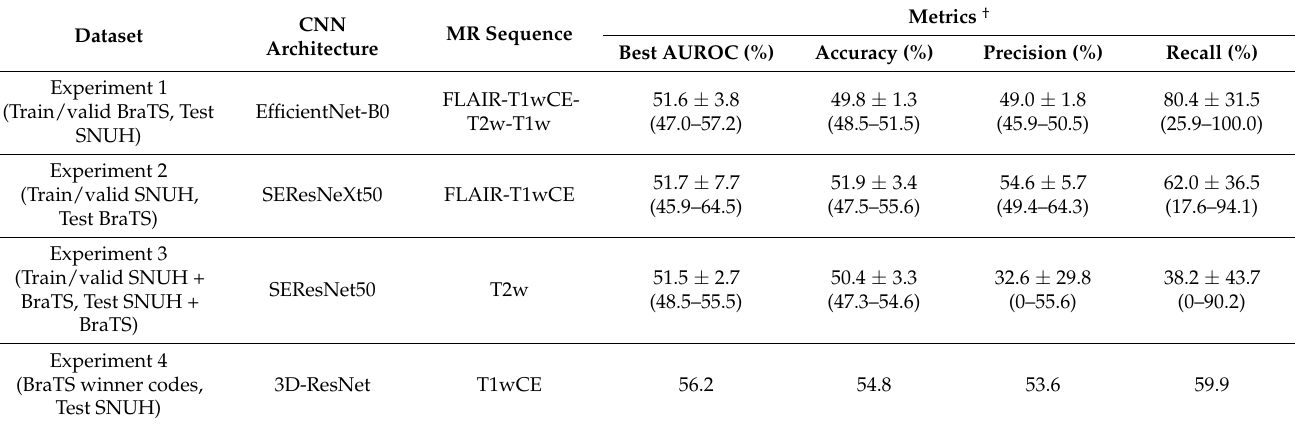
Table 4. Comparison of model performance using different models and sequences in test